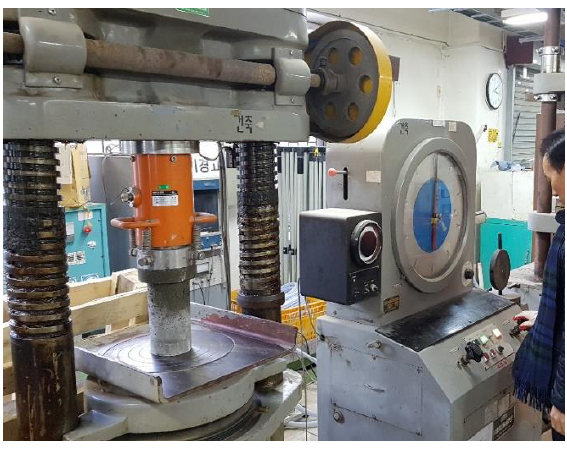
Figure 2. Experiment of ultrasonic pulse velocity method.